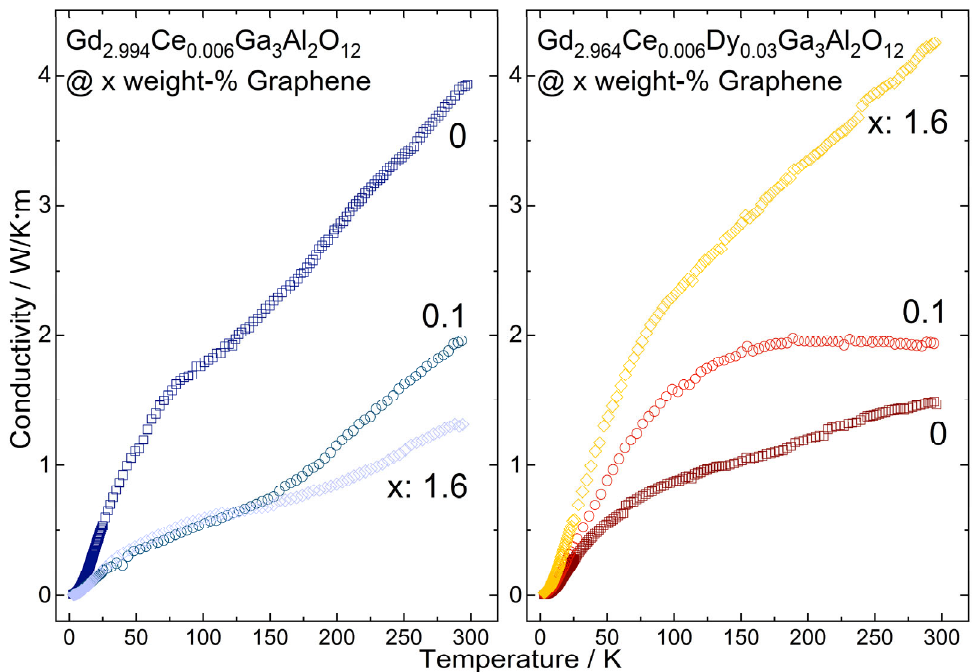
Figure 9. Thermal conductivity of Gd 2.994 Ce 0.006 Ga 3 Al 2 O 12 and Gd 2.964 Ce 0.006 Dy 0.03 Ga 3 Al 2 O 12 ceramics with different graphene content.